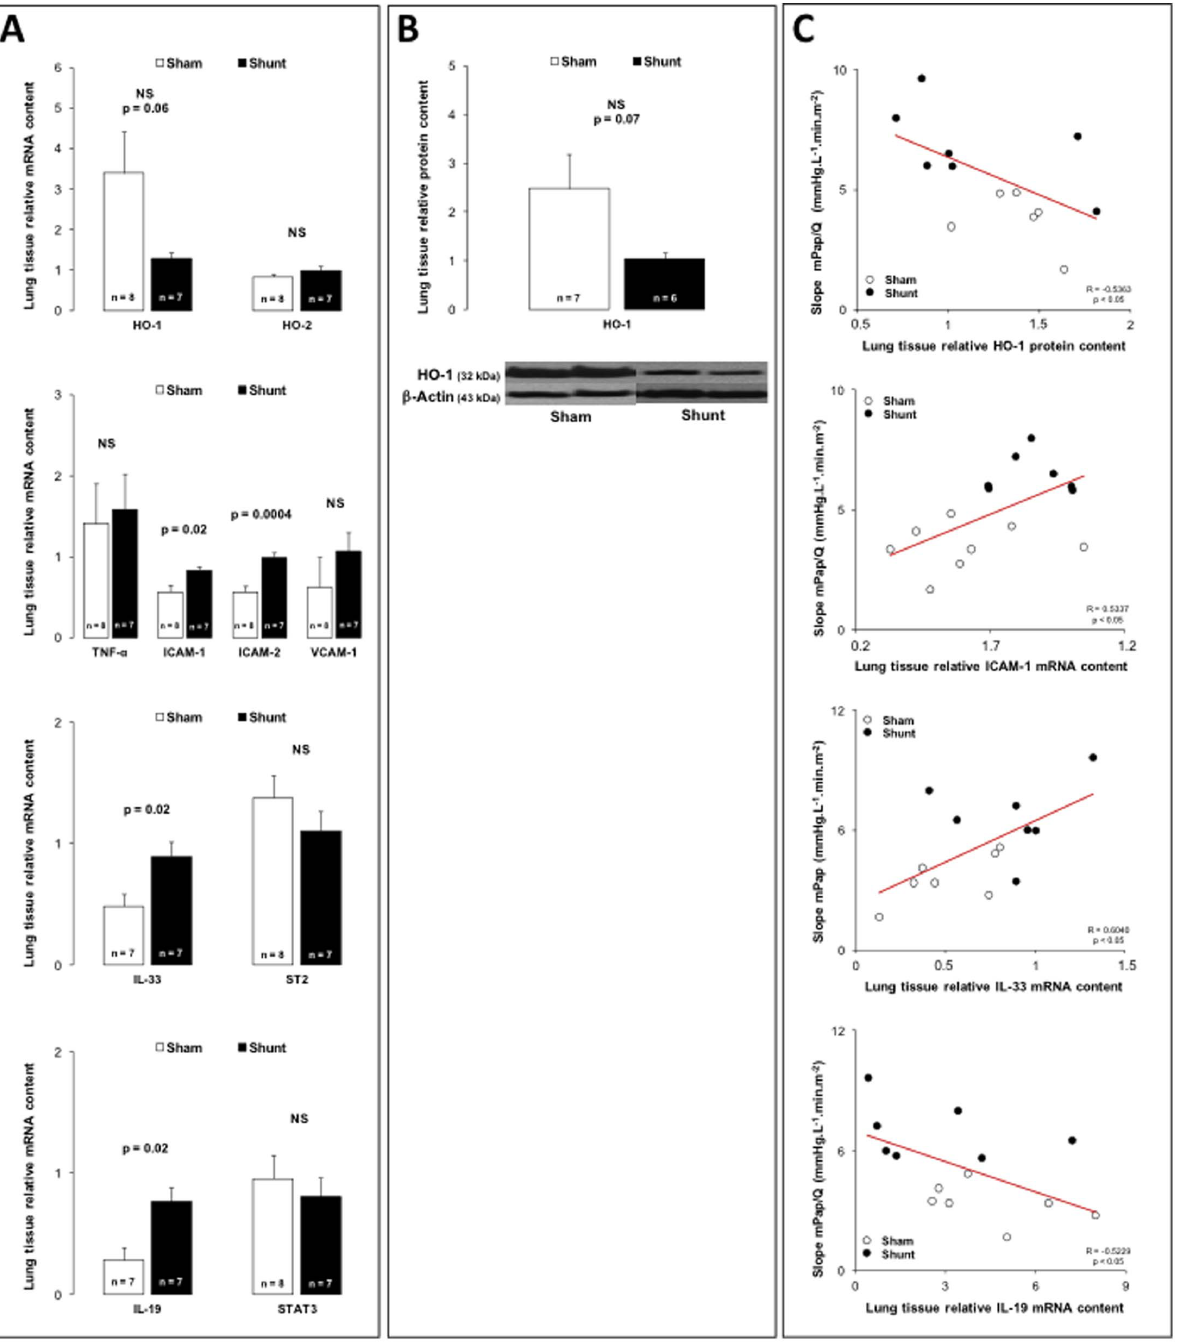
Figure 3. Panel A: Relative lung tissue mRNA content for the heme-oxygenase(HO)-1 and -2 tumor necrosis factor(TNF)- a , intercellular adhesion molecule(ICAM)-1 and -2, vascular cell adhesion molecule(VCAM)-1, interleukin(IL)-33, interleukin 1 receptor-like 1 (ST2), interleukin(IL)-19 and signal transducer and activator of transcription(STAT)-3 in 6-month sham (white bars) and 6-month shunt (black bars) piglets . Panel B: Relative lung tissue protein content for the heme-oxygenase(HO)-1 in 6-month sham (white bars) and 6-month shunt (black bars) piglets. Panel C: Correlation between slope of mPpa/Q relationships and lung protein content for heme- oxygenase(HO)-1, lung mRNA content for intercellular adhesion molecule(ICAM)-1, interleukin(IL)-33 and interleukin(IL)-19. Values expressed as mean 6 SEM.